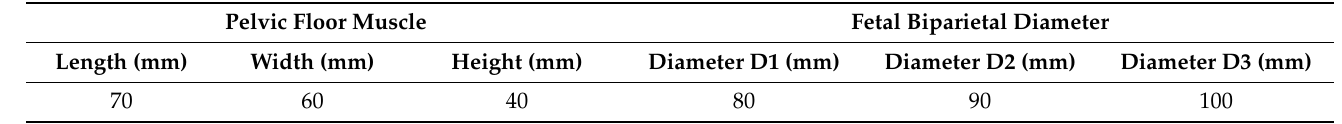
Table 1. Model dimensions.